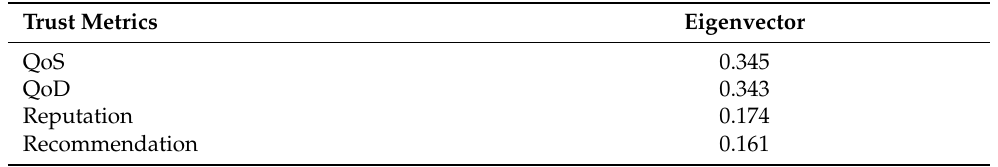
Table 9. EV on trust metrics for Scenario